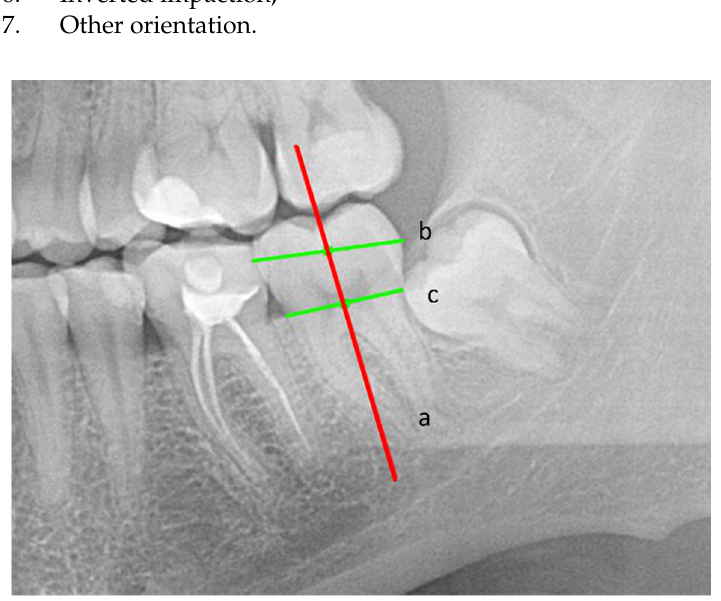
Figure 2. The long axis of the tooth ( a ), greatest width of the tooth crown ( b ), tooth neck ( c )